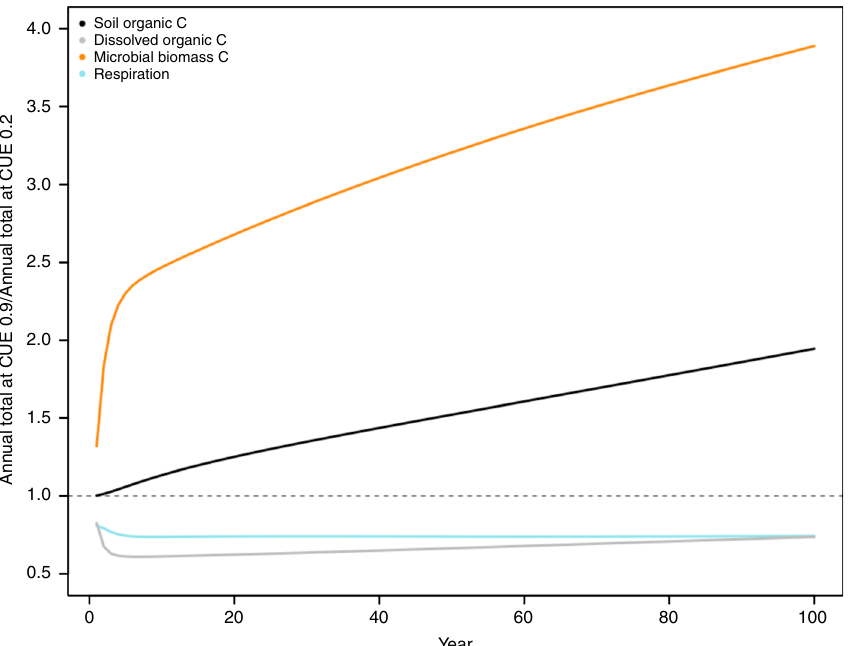
Fig. 6 Ecosystem C stocks and fl uxes with variable microbial communities. Annual totals for C cycle pools and respiration rates for models for high ef fi ciency taxa (CUE = 0.9) relative to low ef fi ciency taxa (CUE = 0.2) across 100 years. Dashed line represents no difference in model estimates at the two CUE